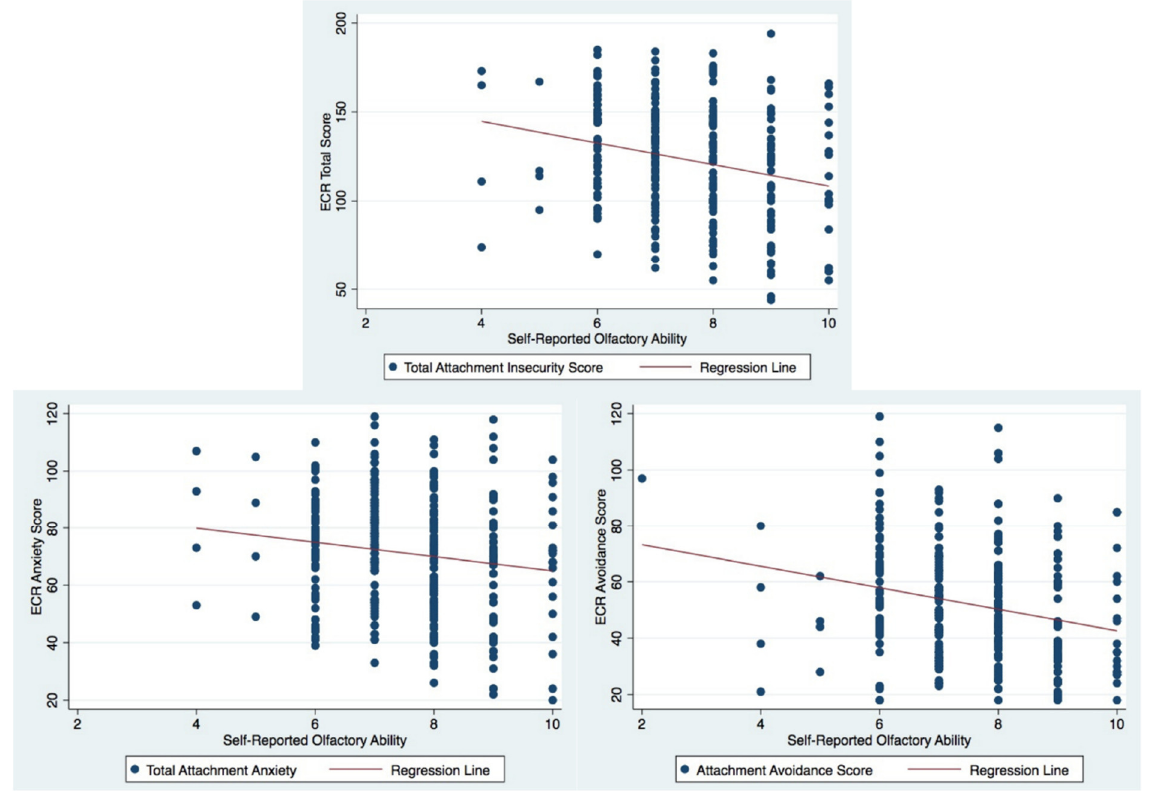
Figure 1. Raw data scatterplots between self-reported olfactory ability and attachment measure scores for females. To evaluate whether the relationship factors were associated with attachment styles per the final hypothesis, Spearman rank order correlations were conducted between the attachment measures and relationship variables. Results (see Table 3) indicated a similar pattern of results between males and females whereby all attachment measures were moderately negatively correlated to number of serious partners and relationship length. Table 3. Correlations Between Attachment and Relationship Measures by Gender.